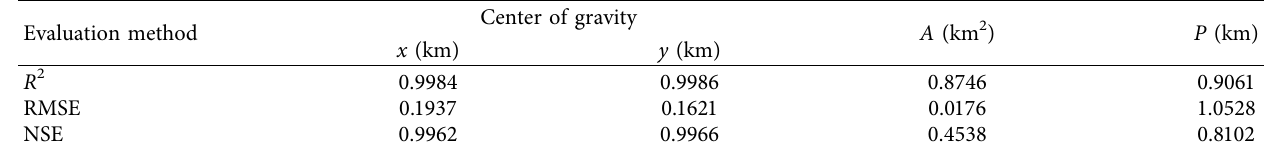
Figure 9: Threshold of the SIND Table 5: Estimation of shape parameter.